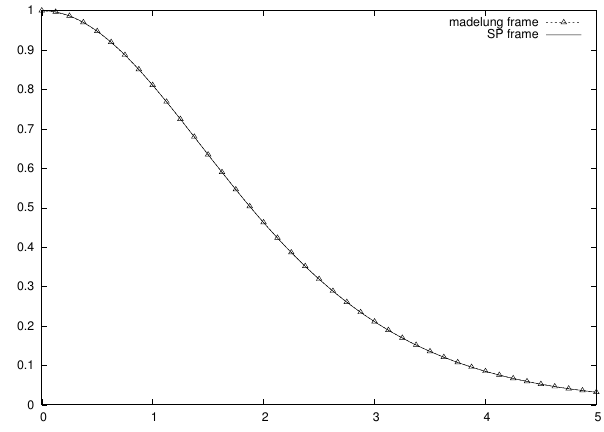
Figure 1. Densities | ψ | 2 and ρ of the ground state equilibrium solution in the SP and the Madelung frames, respectively. In the SP frame, Equations (10) and (11) are solved for the central wave function ψ c = 1. In the Madelung frame Equations (14)–(18), we use the central density ρ c = 1. The numerical solution is constructed on a discrete domain with resolution ∆ r = 2.5 × 10 − 4